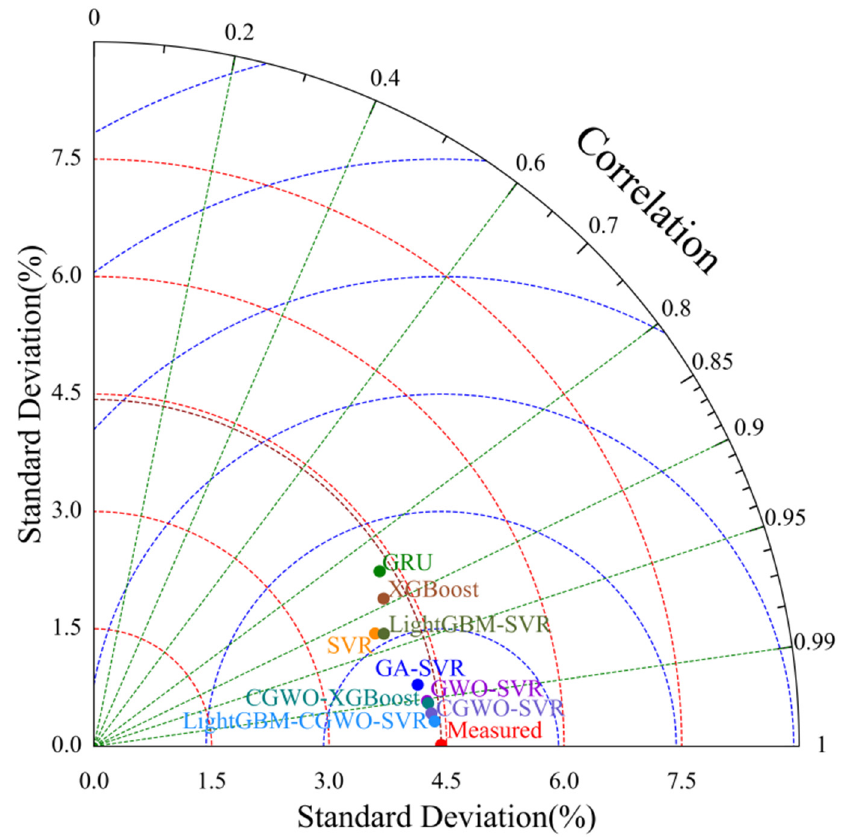
Figure 9. Taylor schemes of actual versus computed humidity (validation level).